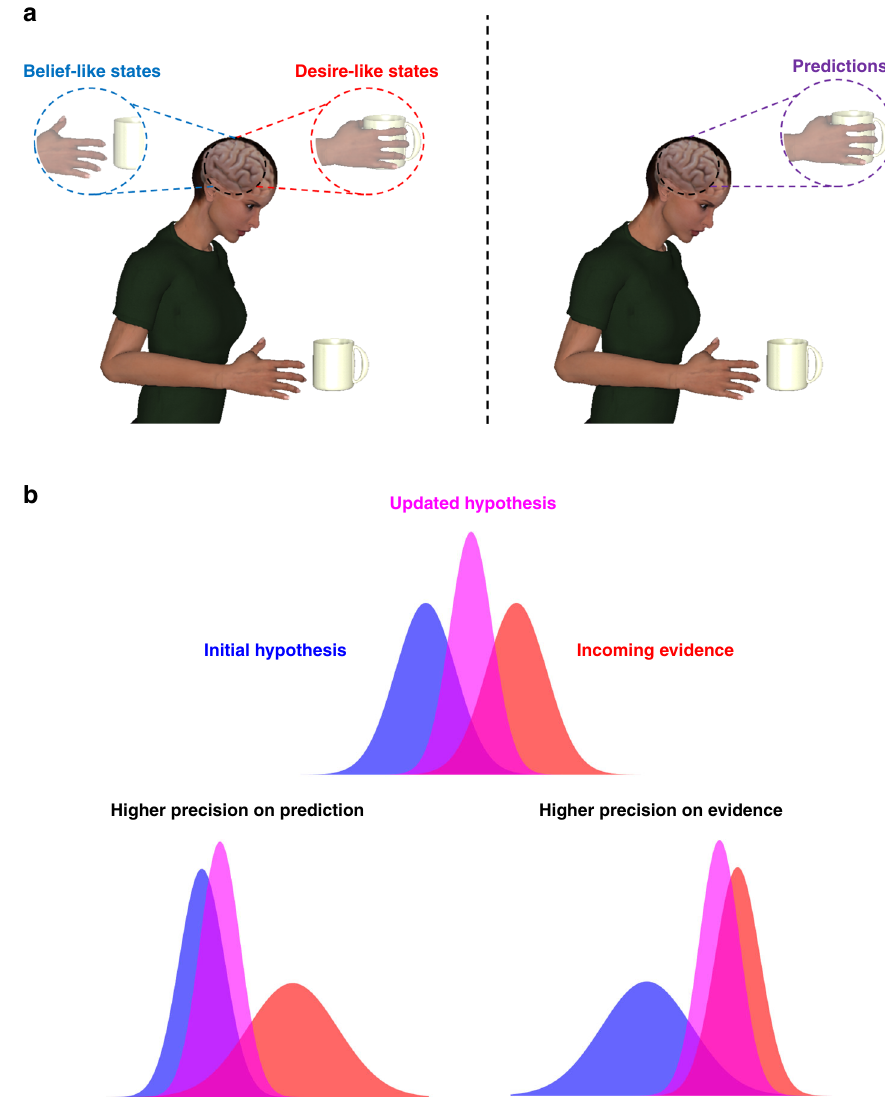
Fig. 1 Beliefs, desires, predictions and precision. a Left: Classic approaches across the cognitive sciences assume that behaviour is controlled by separate mechanisms representing likely (belief-like) and valuable states of the world (desire-like). Right: However, recent predictive processing models assume behaviour can be explained entirely in terms of predictions — describing a desert landscape view of the mind that dispenses with goals, drives and reward. b Predictive processing accounts suggest we re fi ne our internal models of the world by combining initial hypotheses with incoming evidence. In these theories, how (or whether) our hypotheses become updated depends on beliefs about the precision of these two quantities. When agents believe prior predictions are more precise than incoming evidence (bottom left) hypotheses are stubborn and more closely resemble our initial expectations 19 . Conversely, when agents believe sampled evidence is more precise (bottom right), incoming signals have a larger impact on subsequent hypotheses about the world (Box or ‘ error ’ between prediction and reality. This structure allows the drives and desires — are reduced to predictions. Under this account “ there is no essential difference between goals or desires and brain to optimise its fi t to the outside world through two kinds of process or ‘ inference ’ . The fi rst is perceptual inference, where